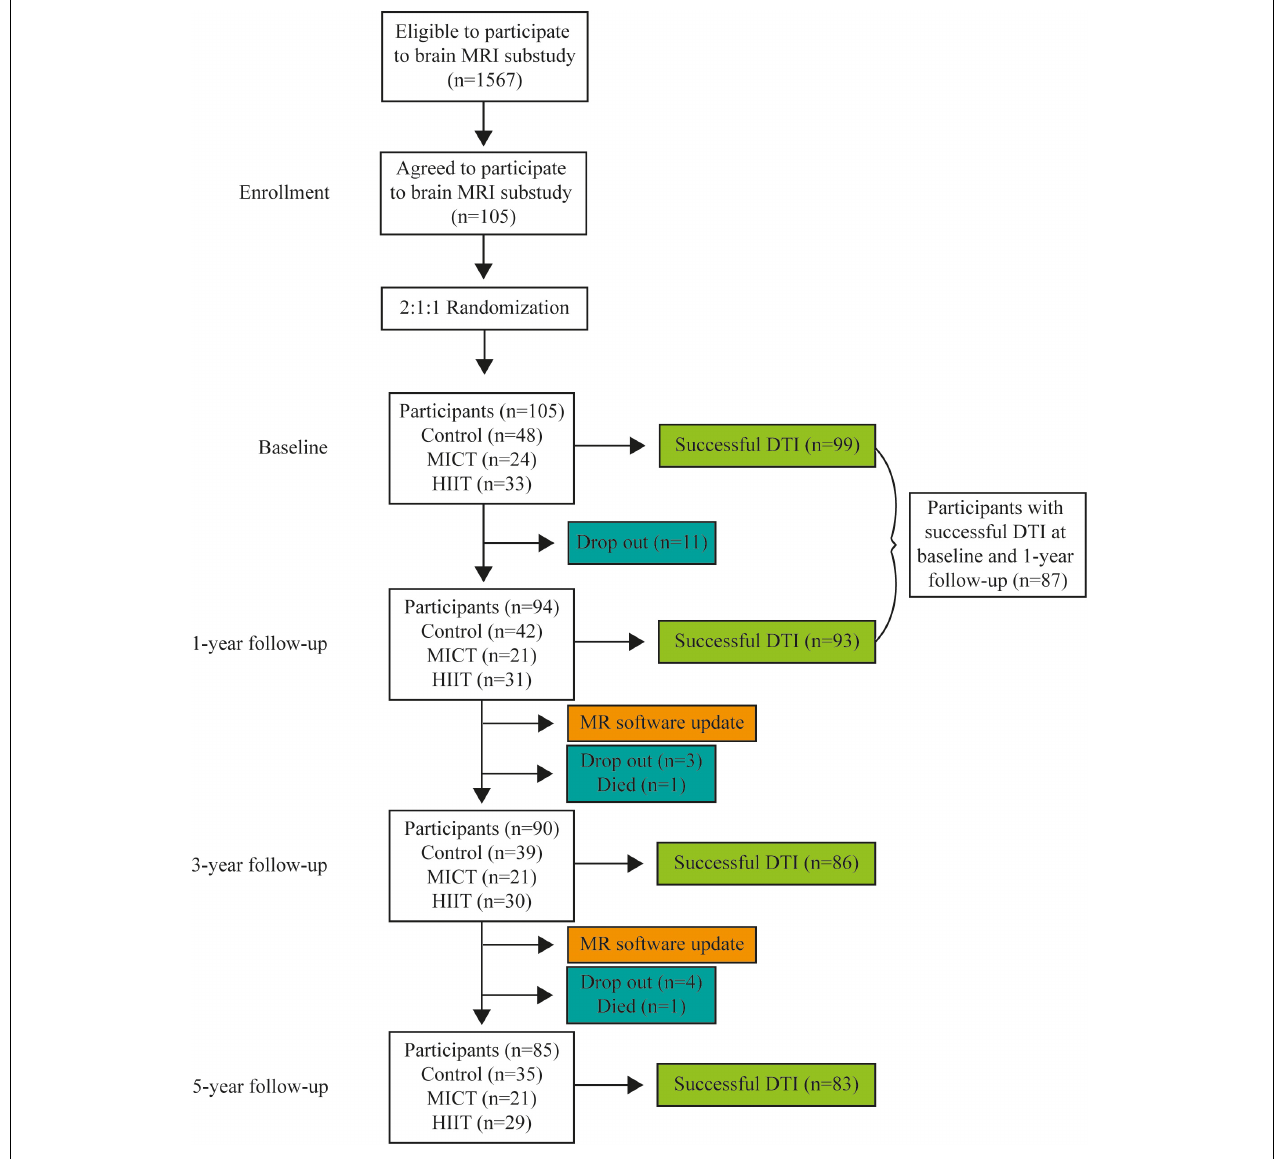
FIGURE 1 | Flowchart of the number of participants (n) in total and each group at every time point and the number of successful DTI scans at each time point. HIIT, high-intensity interval training; MICT, moderate-intensity continuous